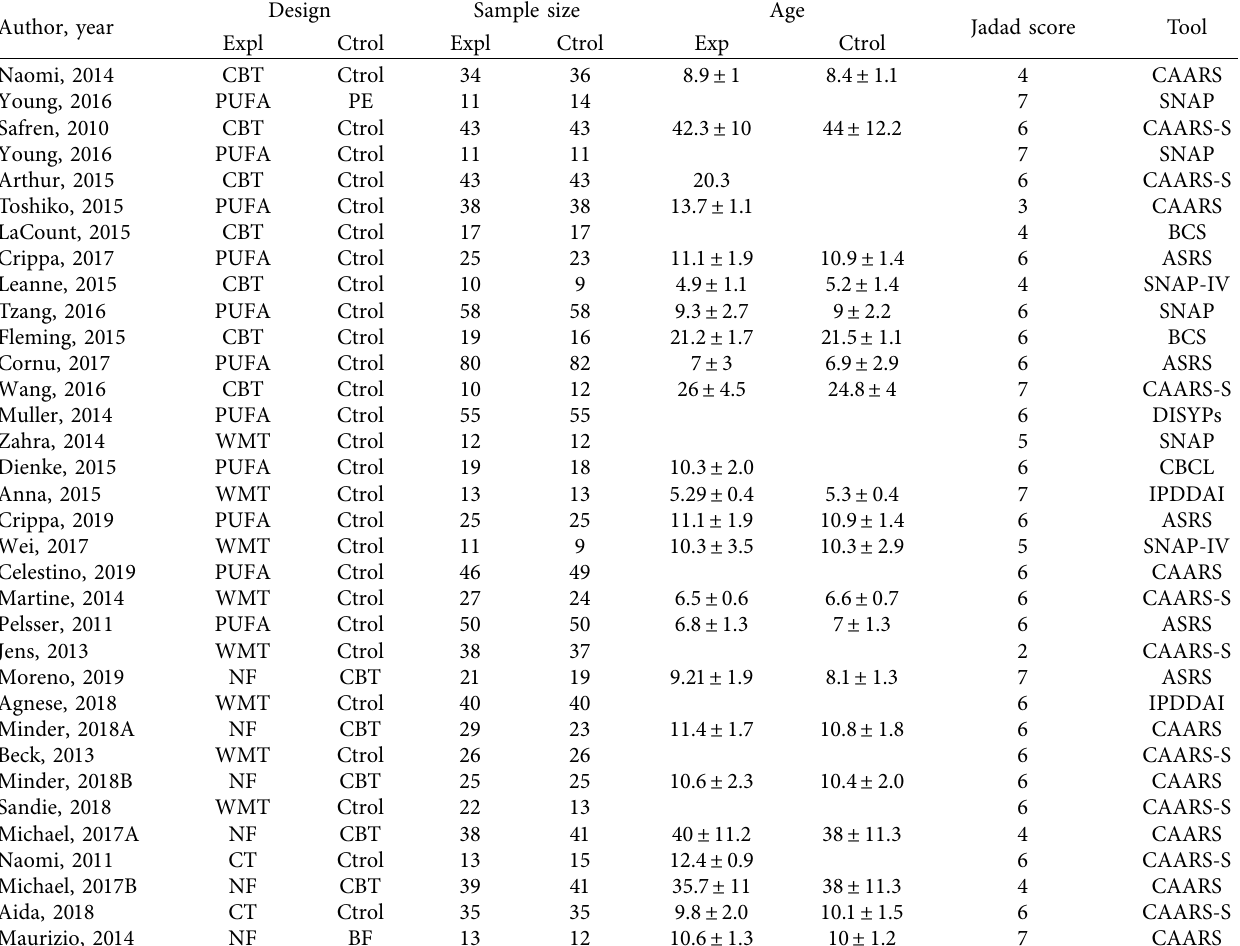
Table 1: Characteristics of included